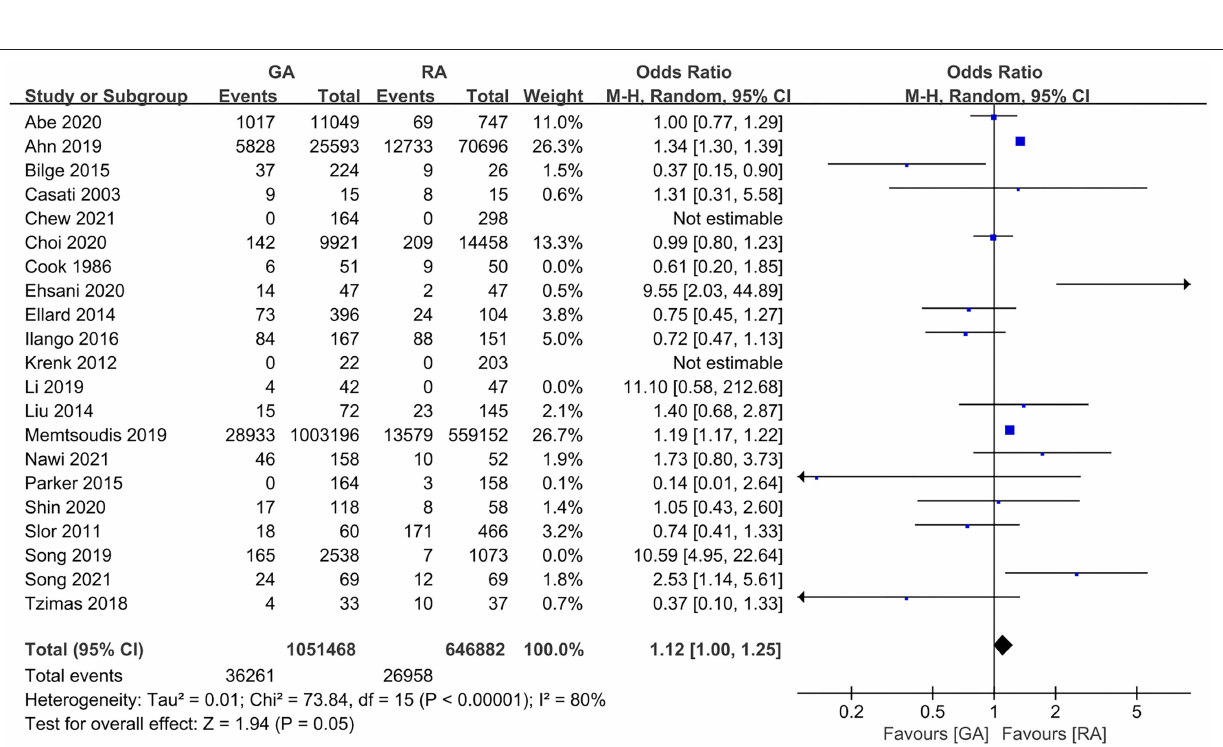
Frontiers in Medicine |